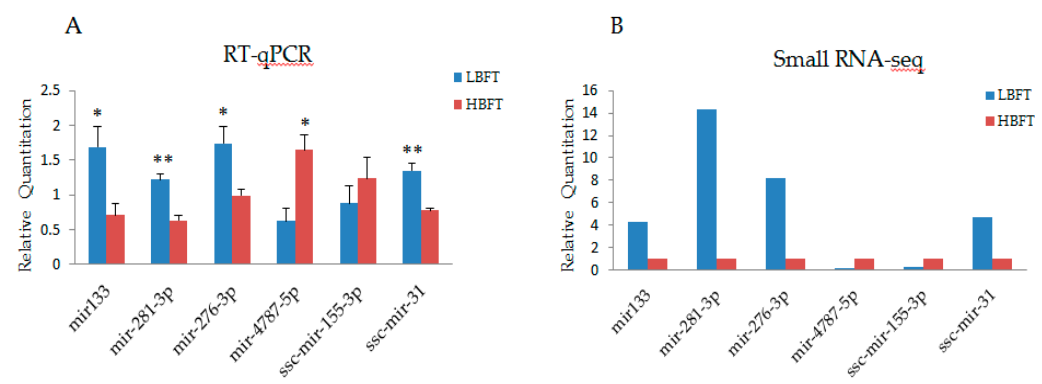
Figure 3. Validation of small RNA-sequencing data using reverse transcription real-time quantitative polymerase chain reaction (RT-qPCR) ( A ), RT-qPCR results of six selected miRNAs ( B ), and small RNA-seq results of six microRNAs (miRNAs) (Y-axis represents that the transcripts per million (TPM) of each gene in low-backfat thickness (LBFT) and high-backfat thickness (HBFT) groups was normalized by TPM of LBFT).